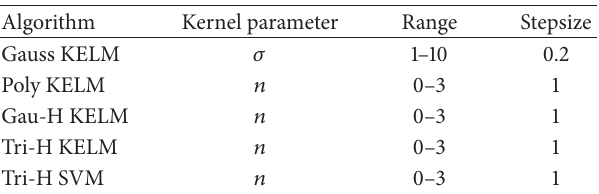
Table 2: The various algorithms and the range of their kernel parameters.